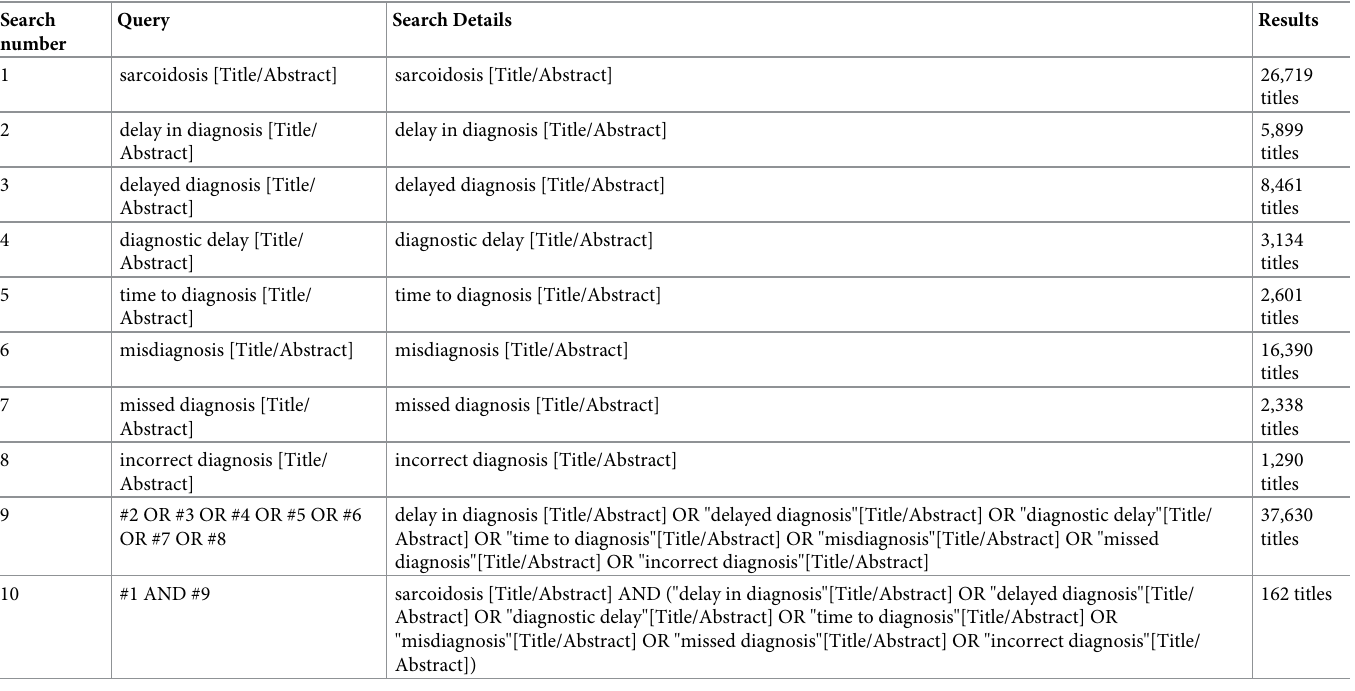
Table 1. Search string conducted on Pubmed/Medline.